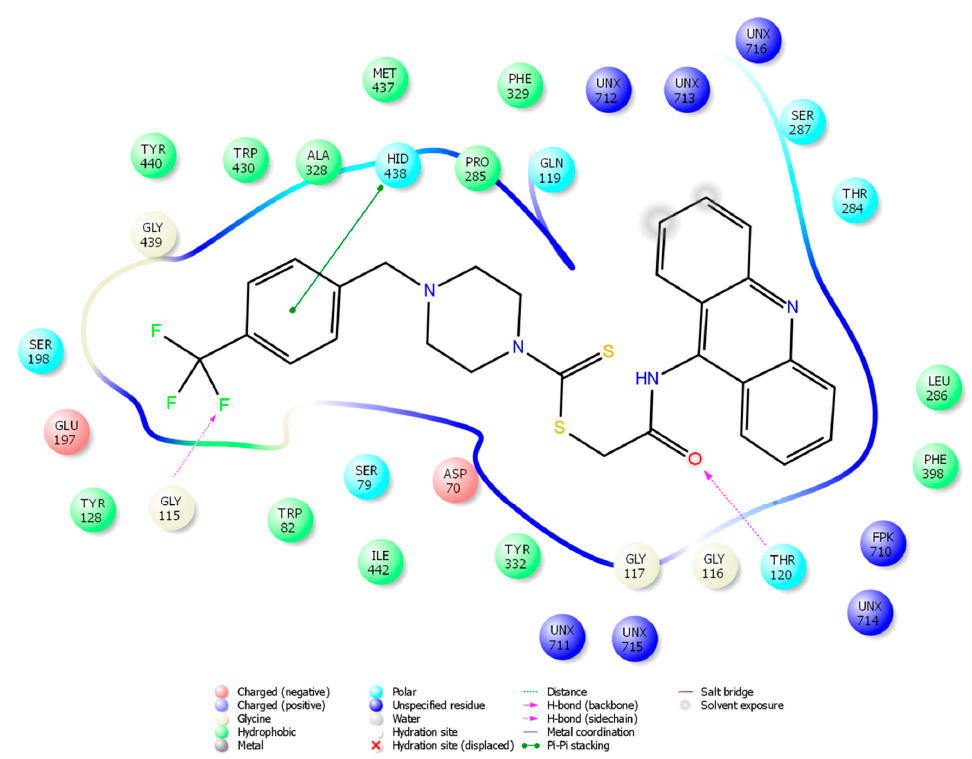
Figure 4. Two-dimensional interaction of compound 4n with BChE.